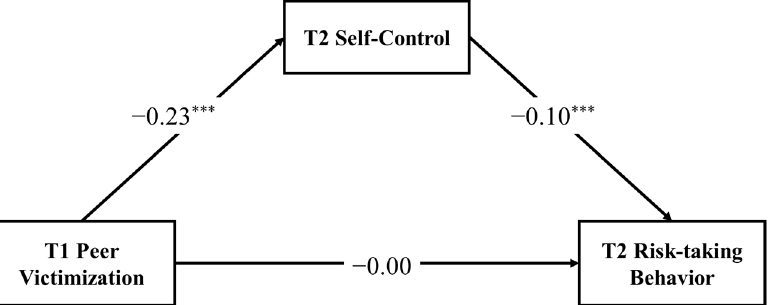
Figure 2. The mediating effect of self-control in the relationship between peer victimization and risk-taking behavior. Note: Unstandardized coefficients are reported. T1 = Time 1, T2 = Time 2; *** p < 0.001. Table 2. Summary of the direct and indirect